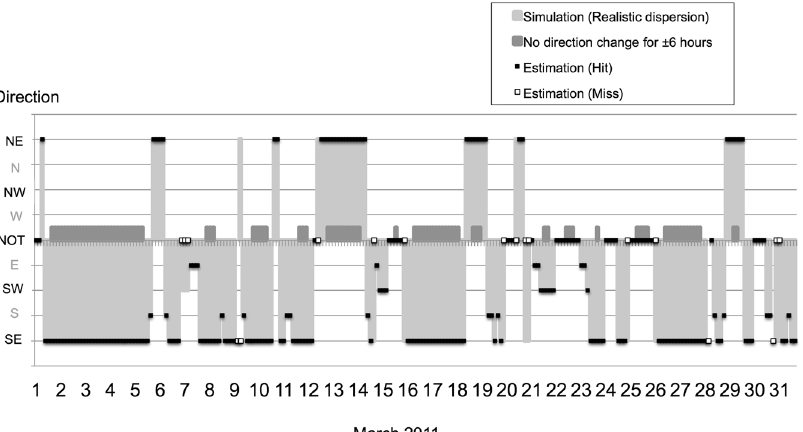
Figure 3. Temporal variations in realistic and estimated directions in March 2011. The realistic dispersion directions are obtained by the dispersion distribution of the output from LT simulation (light shading). The estimated directions are obtained by applying the SVM machine learning method to the 10-m near- surface winds extracted from the MSM-GPV data. The filled square markers and the square markers with white interiors indicate successful and failed predictions, respectively. The dark areas indicate cases in which no change in direction occurred for 6 hours before and after the predictions. This graph was created using Microsoft Excel for Mac